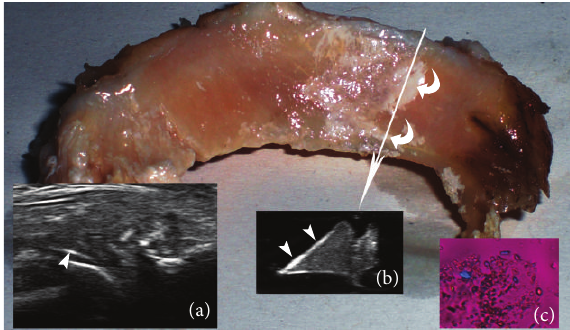
Figure 2: Superficial CPP deposits in the meniscus (curved arrows). Frame (a): the appearance of these deposits in the in vivo exam- ination (arrowheads). Frame (b): ex vivo US transverse scan of the meniscus at the level of the arrow. The arrowheads highlight a hyperechogenic line on the surface of the meniscus, corresponding to the CPP deposits. Frame (c): microscopic analysis of a sample of the meniscus surface, confirming the presence of CPP